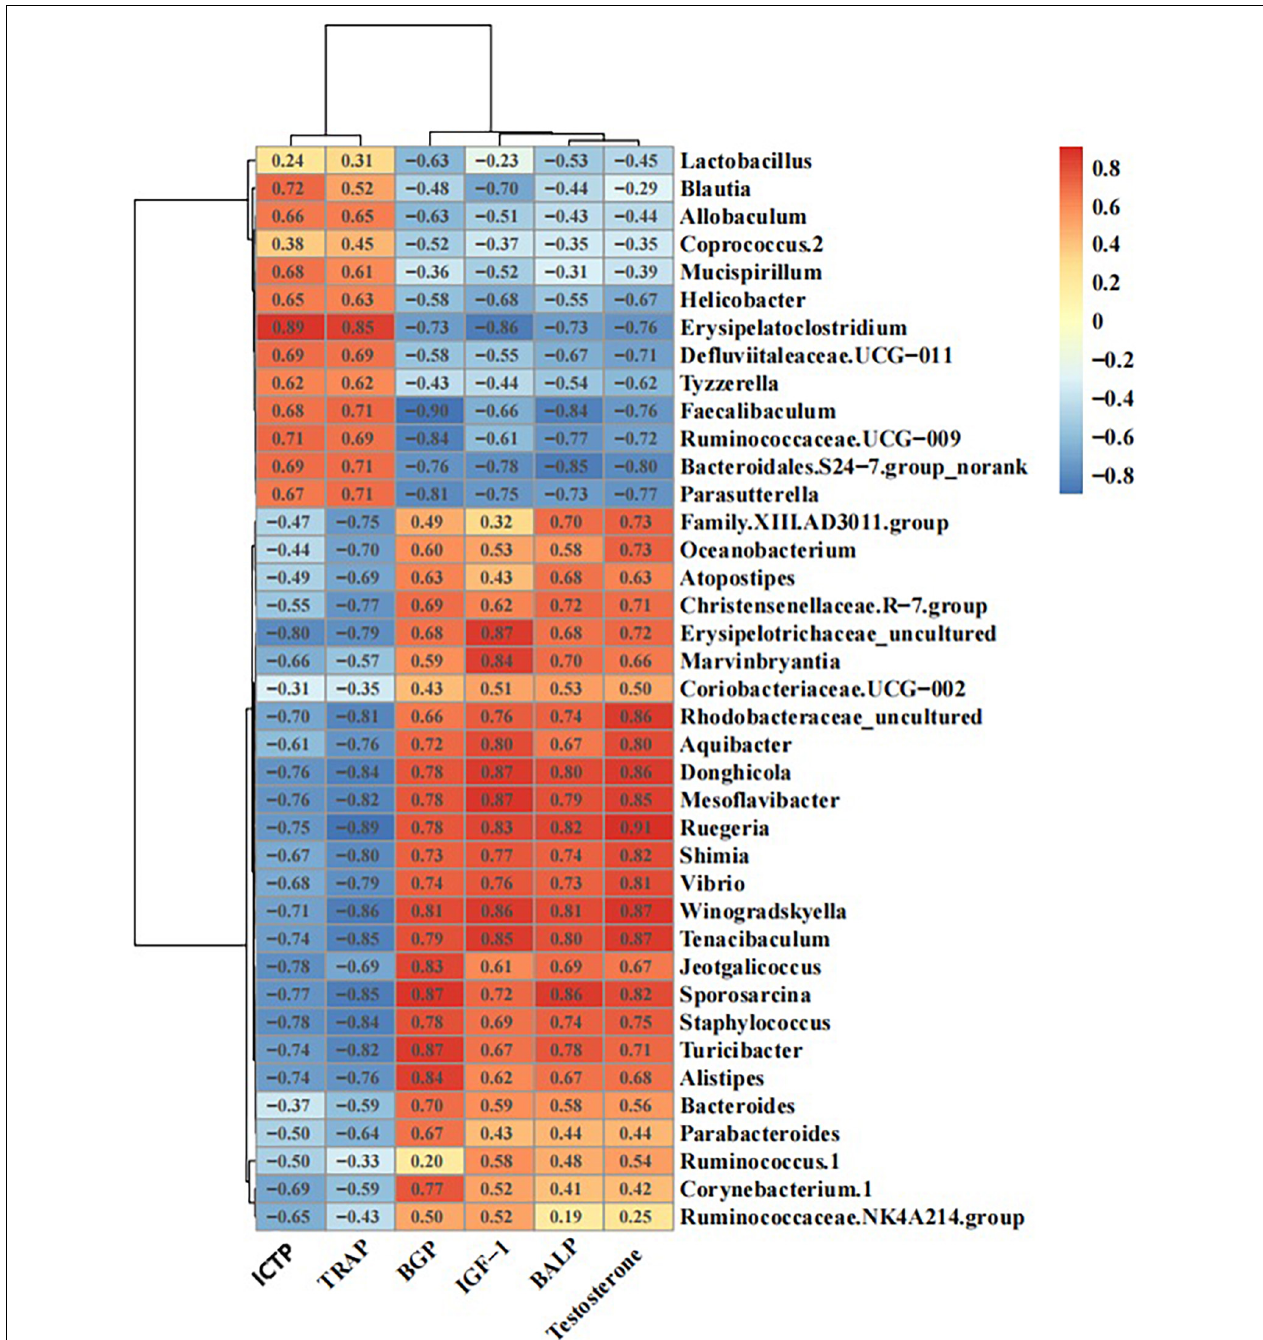
FIGURE 9 | Schematic diagram of the correlations between bone metabolic indices and intestinal flora.